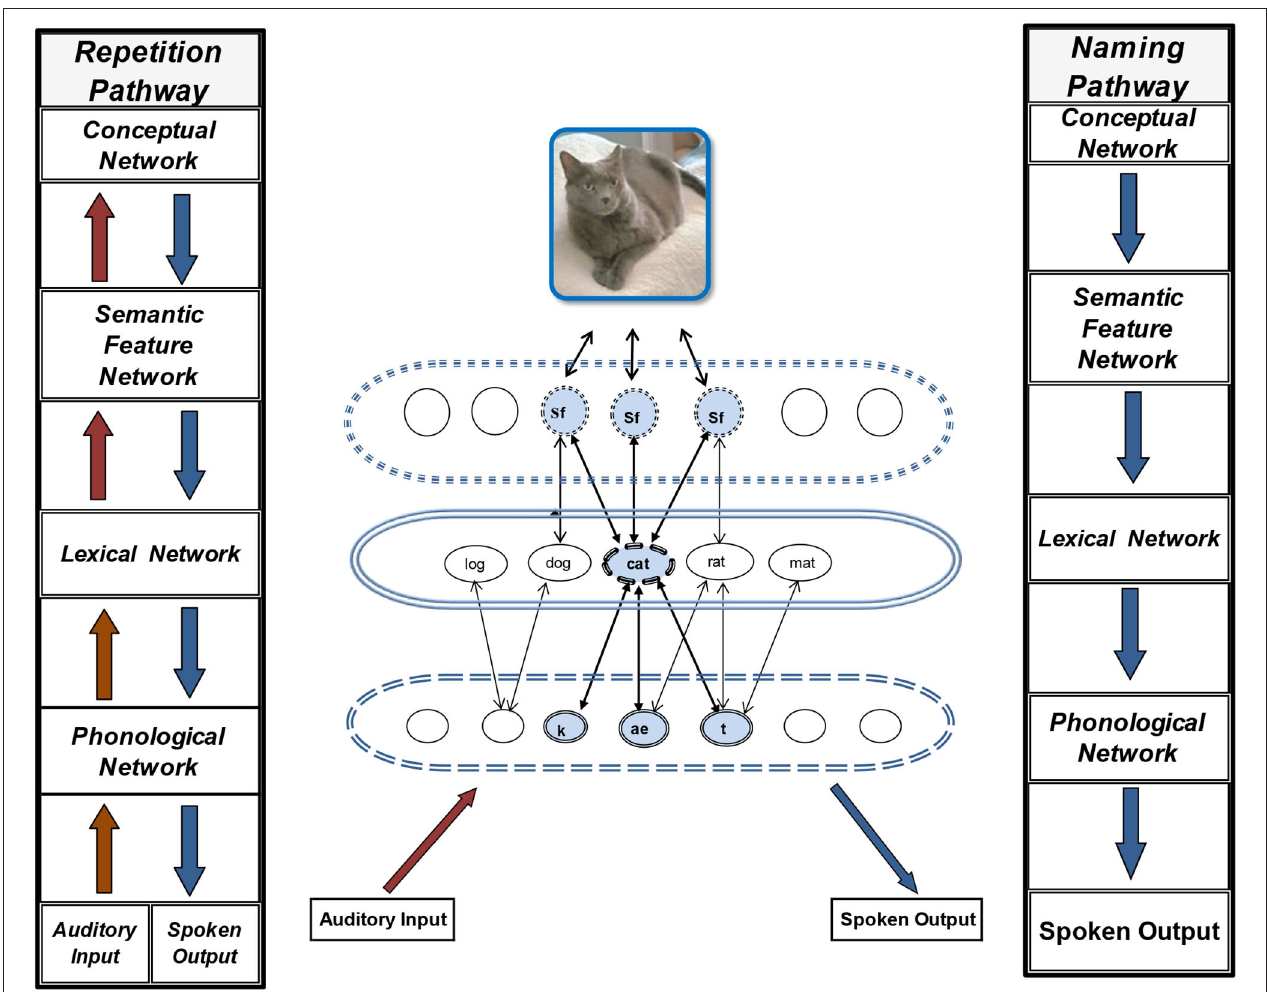
FIGURE 1 | Depiction of the interactive activation semantic-lexical-phonological network for word processing plus two abstracted depictions of the directional flow of activation spread through this network in word repetition and word